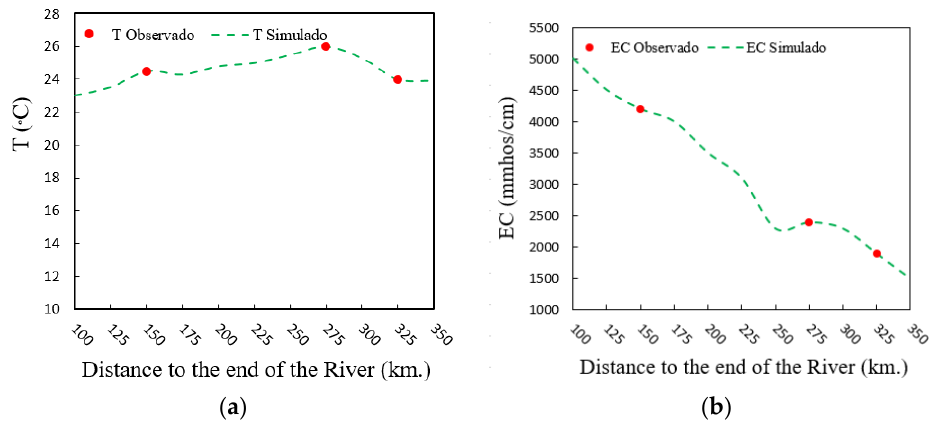
Figure 9. ( a ) Temperature; and ( b ) EC simulations along the Maroon and Jarahi Rivers.